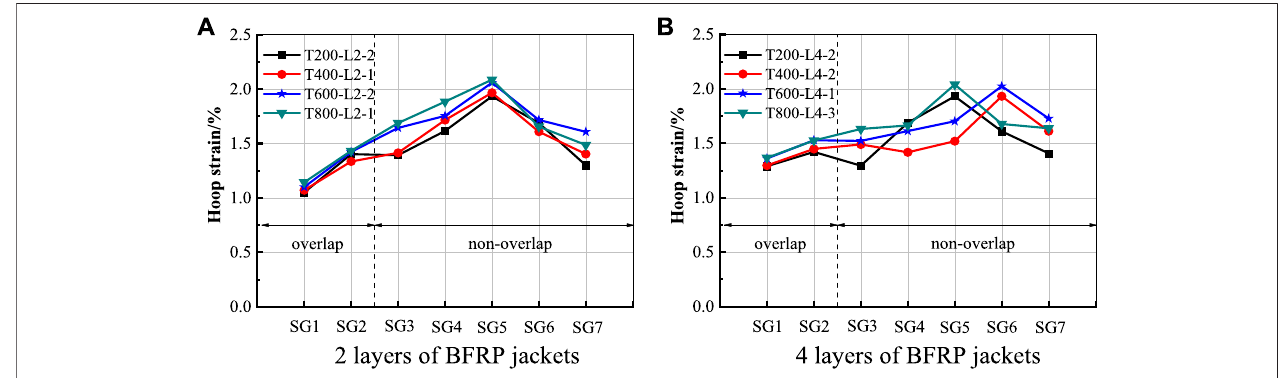
FIGURE5| Straindistributionsofheat-damagedconcretecylinderscon fi nedwithdifferentlayersofBFRPjackets. (A) TwolayersofBFRPjackets, (B) fourlayersof BFRP jackets.